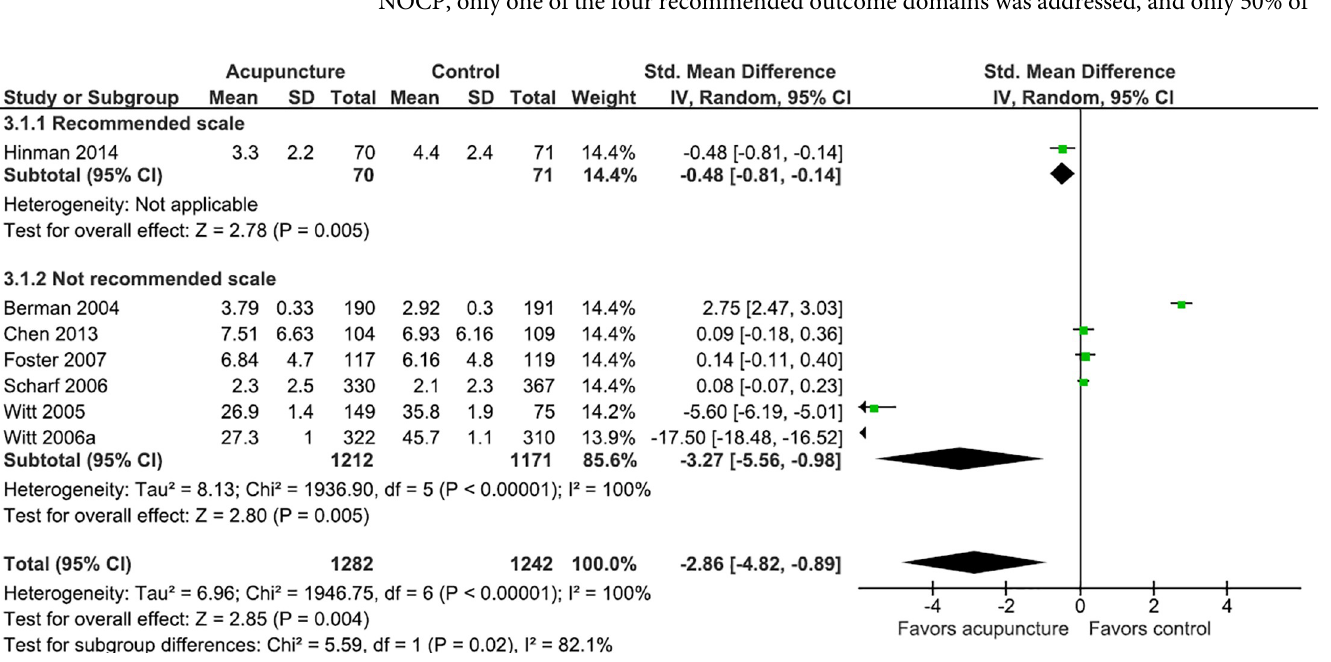
Fig 5. Meta-analysis of the effect of acupuncture in patients with osteoarthritis stratified by the use of recommended scales or not.